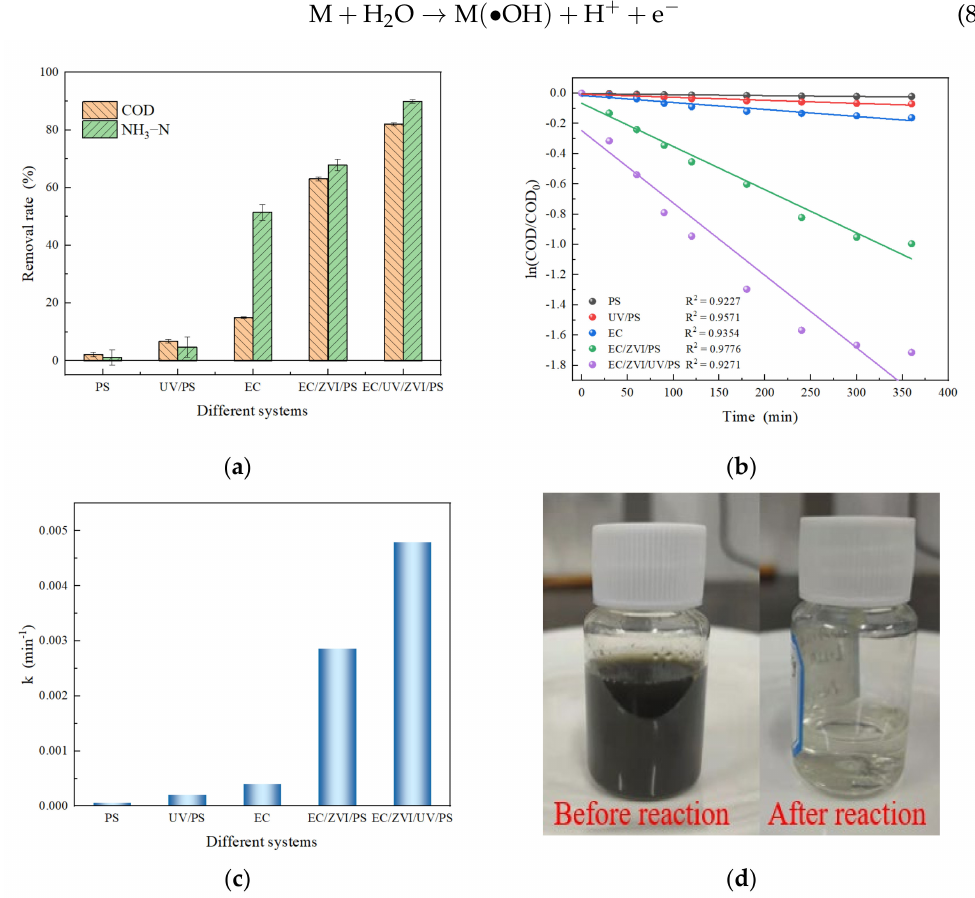
Figure 1. ( a ) Removal efficiencies of COD and NH 3 -N from landfill leachate by different systems. ( b ) Pseudo-first-order kinetic models for COD removal in different systems. ( c ) The k of COD under different reaction systems. ( d ) The state changes of the leachate before and after the treatment of the electro-assisted ZVI/UV combined activated PS system. (Initial pH: 3.0; PS/12COD ratio: 1; ZVI dosage: 1.5 g/L; current density: 62.5 mA/cm 2 ; reaction time: 6